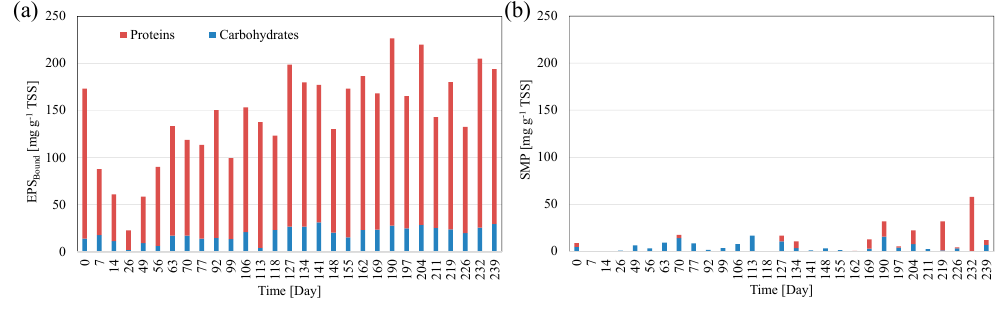
Figure 8. Extracellular Polymeric Substance (EPS) ( a ) and soluble microbial product (SMP) ( b ) concentration during experiment.